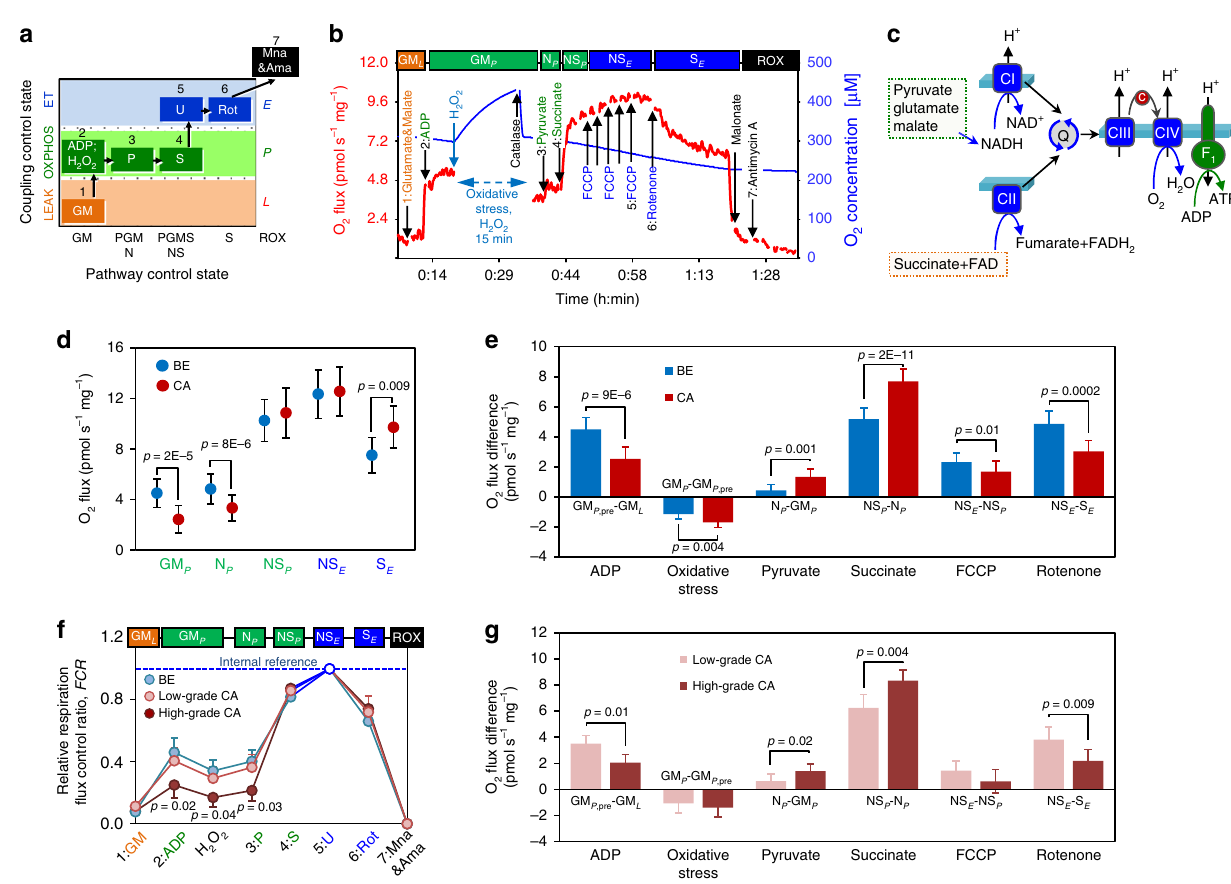
Fig. 2 High-resolution respirometry of prostate tissue samples. a Coupling/pathway control diagram showing the sequential steps in the substrate- uncoupler-inhibitor titration (SUIT) protocol with different coupling states. See Supplementary Tables 1 – 2 for HRR protocol details. b Representative HRR traces with permeabilized tissue. Red line (left Y -axis): wet mass-speci fi c O 2 fl ux (oxygen consumption (pmol s 1 mg − 1 )). Blue line (right Y- axis): O 2 concentration [ µ M]. Substrate-uncoupler-inhibitor titrations are indicated by arrows. Different coupling/pathway control states are indicated in boxes: LEAK (orange); OXPHOS (green); ET (blue); ROX (black). c Schematic representation of mitochondrial electron transfer from NADH-linked substrates through Complexes CI, CIII, and CIV (N-pathway) and from succinate through CII, CIII, and CIV (S-pathway). G, M and P support the N-pathway through CI into the Q-cycle (Q); succinate provides electrons via CII into the Q junction. Electrons are transferred from CIII via cytochrome c (c) to CIV where O 2 is reduced to H 2 O. H + ions are pumped across the mt-inner membrane by CI, CIII, and CIV to generate an electrochemical potential difference across the mt- inner membrane, which drives phosphorylation of ADP to ATP by F O F 1 -ATPase. d Respiratory capacity in benign (blue, N = 50) versus malignant (red, N = 50) tissue samples: OXPHOS-capacity (GM P , N P and NS P ) and ET-capacity (NS E and S E ). e Effects of substrates GM, pyruvate, succinate, oxidative stress, uncoupler FCCP, and CI inhibitor rotenone on O 2 fl ux in benign (blue, N = 50) and malignant (red, N = 50) tissue samples. f . Normalized respiratory capacities of high-grade tumor (Gleason > 7; dark red; N = 10) and low-grade tumor (Gleason ≤ 7, light red, N = 40) compared to benign samples (blue, N = 50). g Effects of substrates, oxidative stress, uncoupler, and CI inhibitor on O fl ux in low-grade (light red, N = 40) and high-grade (dark red, N = 10) 2 tissue samples. Data in (d-g) are presented as mean values ± SD. Statistical differences were tested using two-tailed paired-samples test ( d – e ), one-way ANOVA followed by Tukey ’ s HSD ( f ) or Wilcoxon rank-sum test ( g ), respectively. Correction for multiple testing was performed using the Bonferroni- Holm procedure. Source data are provided as a Source Data fi